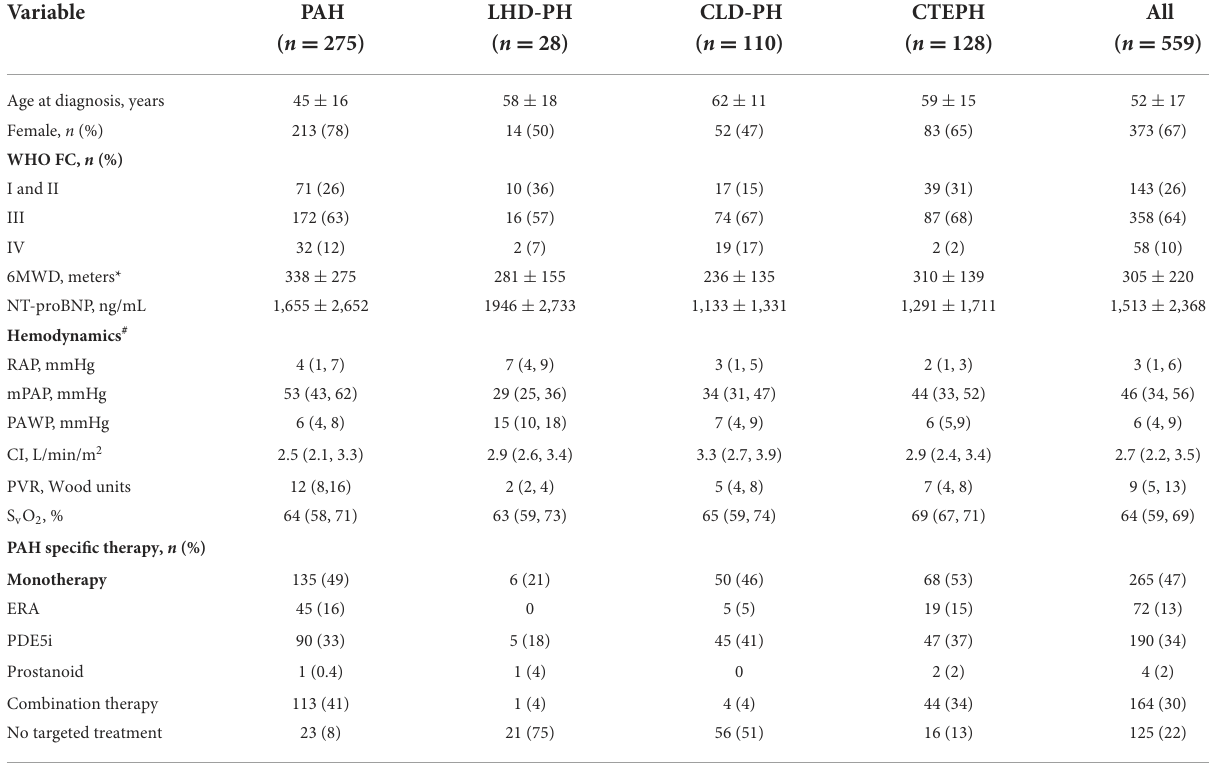
TABLE 1 Baseline demographic and clinical characteristics of patients with main pulmonary hypertension classification.